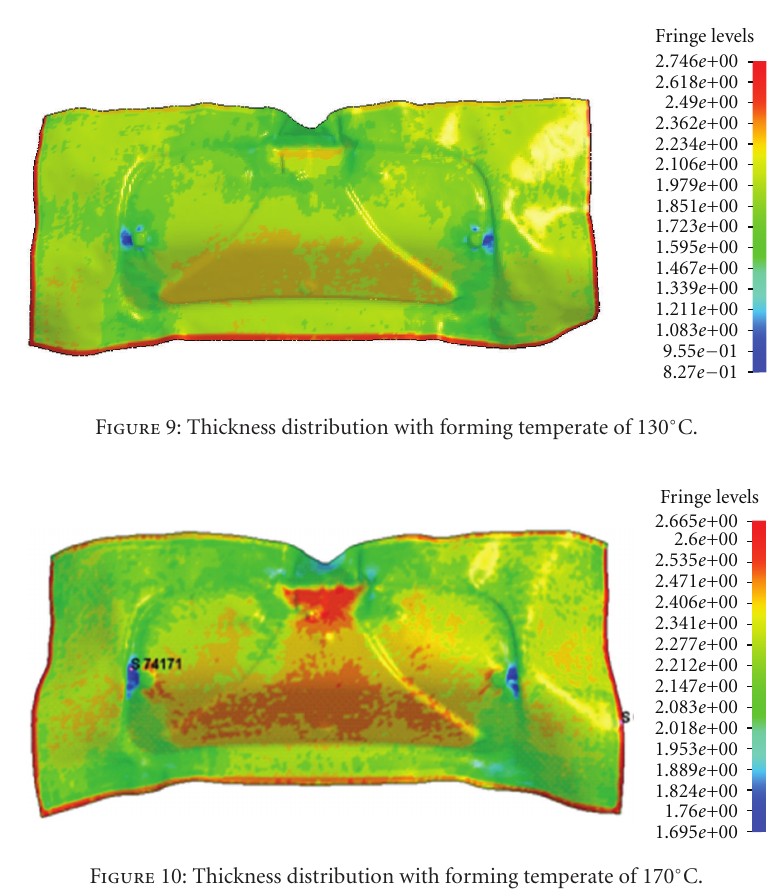
Figure 10: Thickness distribution with forming temperate of 170 ◦